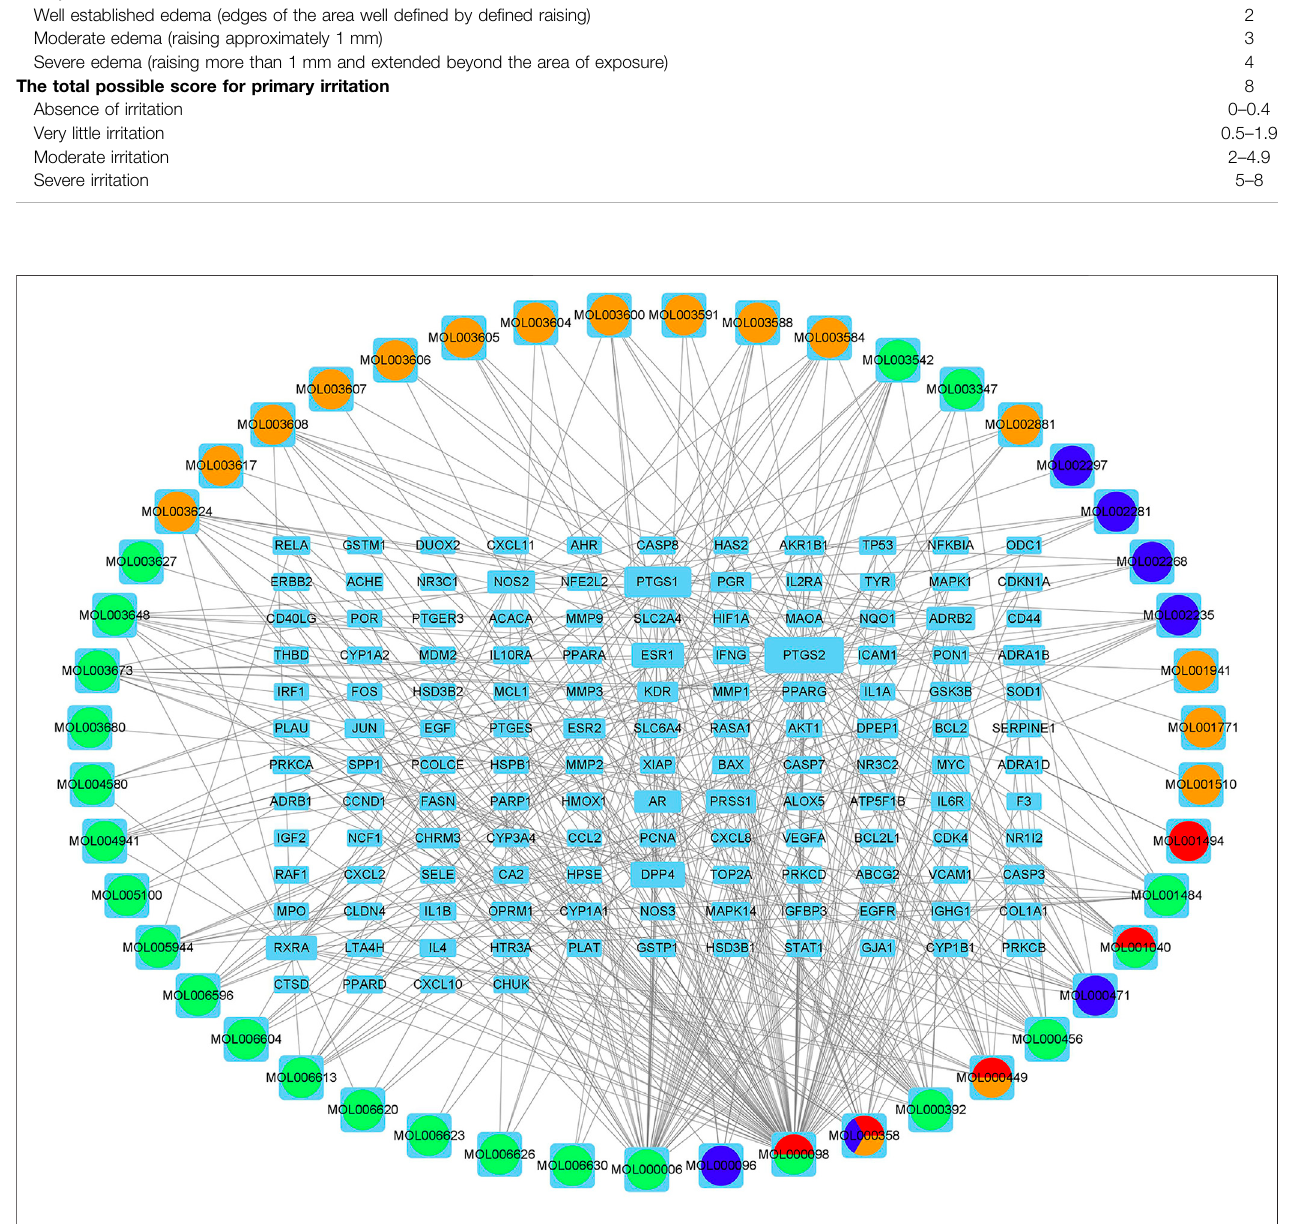
FIGURE 2 | Compound-target